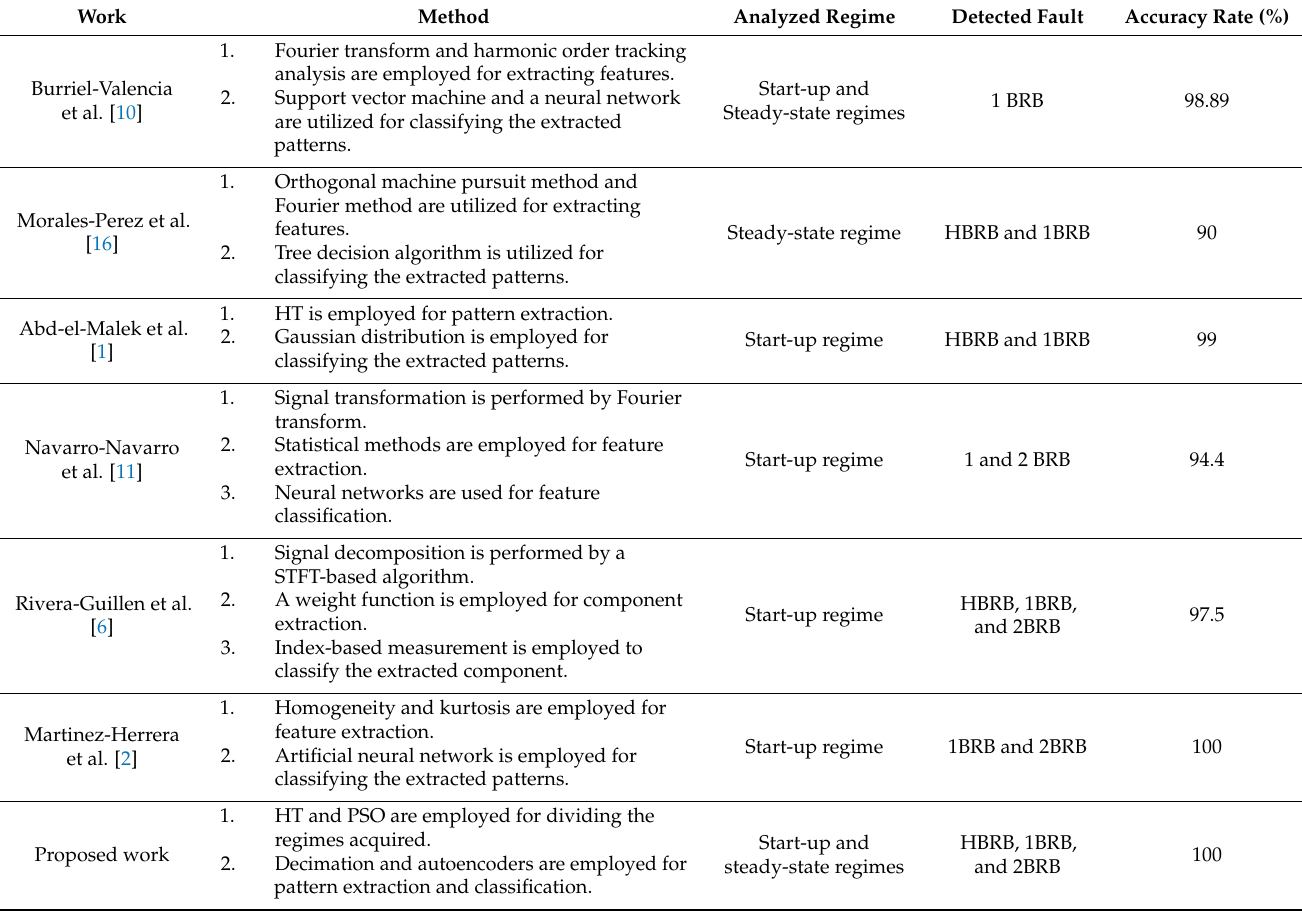
Table 1. Qualitative comparison between the proposed expert system and recent approaches intro- duced in the